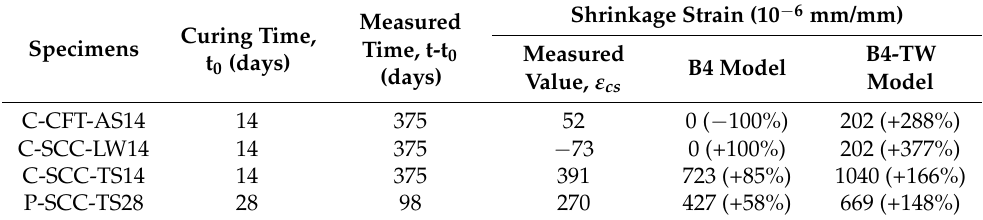
Table 11. Comparison of measured shrinkage and predicted results.